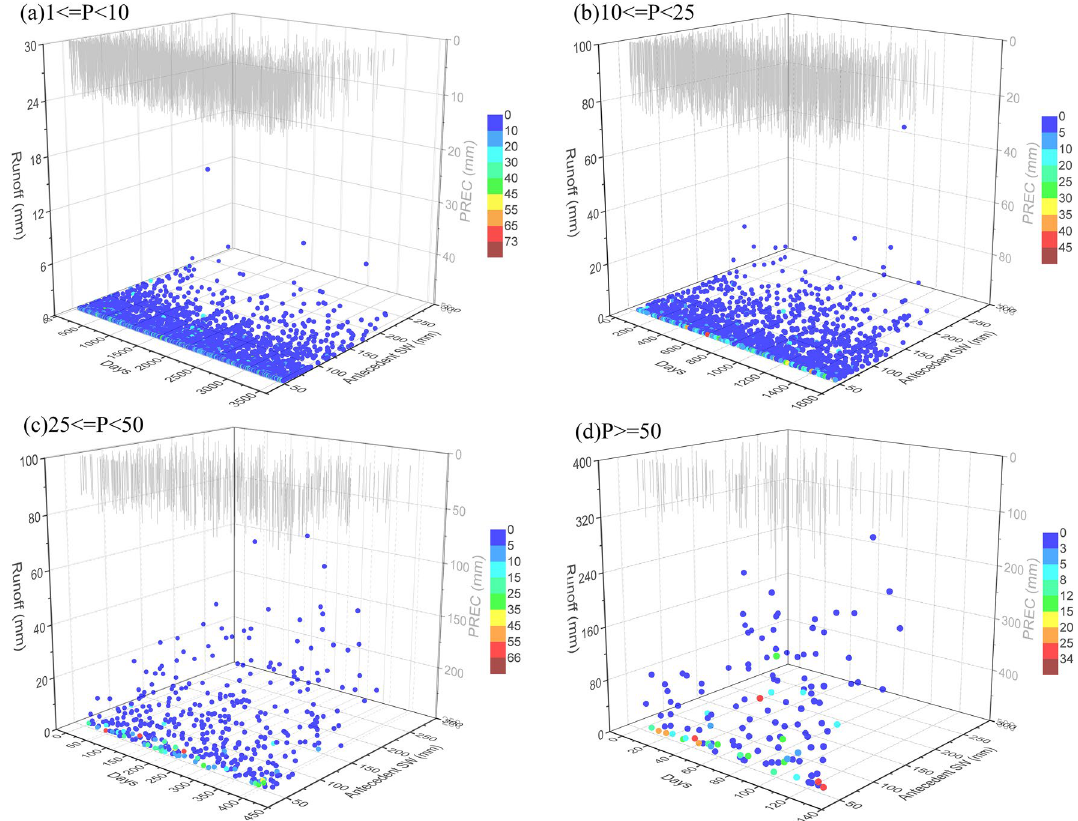
Figure 6. Relationship of runoff with precipitation (PREC, mm), antecedent drought days, and antecedent soil water (antecedent SW, mm) at different precipitation amounts: ( a ) light rain (1 ≤ P < 10 mm), ( b ) moderate rain (10 ≤ P < 25 mm), ( c ) heavy rain (25 ≤ P < 50 mm), and ( d ) rainstorm (P ≥ 50 mm). Graphs were created using OriginPro software version 9.0 (https:// www. origi nlab.